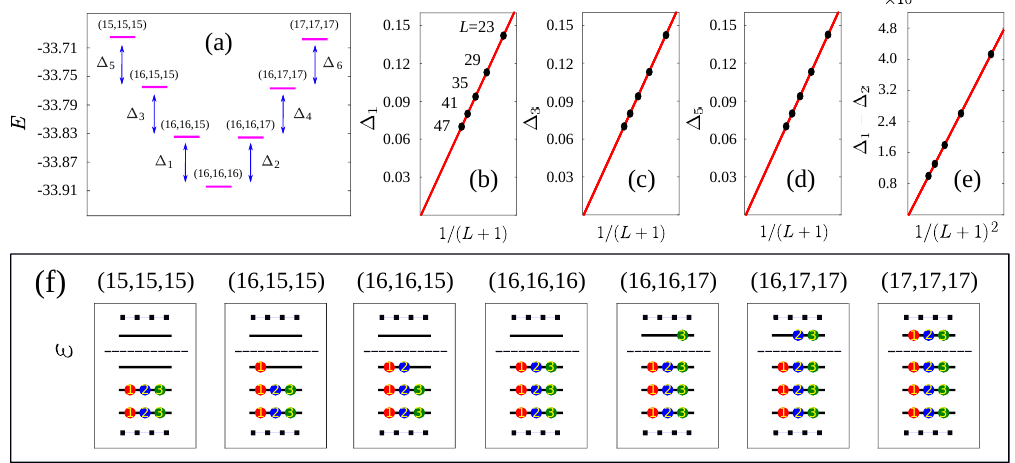
Figure 3 . (a) Energy spectrum of the SU(3) model with L = 47. Quantum numbers for each column are given as ( N f 1 ; N f 2 ; N f 3 ) in the panel. (b)-(e) Finite-size scaling of (cid:1) 1 ; 3 ; 5 and (cid:1) 1 (cid:0) (cid:1) 2 in the energy spectrum. 1 = ( L + 1) scaling is also observed in (cid:1) 2 ; 4 ; 6 and 1 = ( L + 1) 2 scaling is also observed in (cid:1) 3 (cid:0) (cid:1) 4 ; (cid:1) 5 (cid:0) (cid:1) 6 . (e) Schematics of the Fermi liquid picture for the energy spectrum. The colored dots with numbers 1 ; 2 ; 3 represent conduction